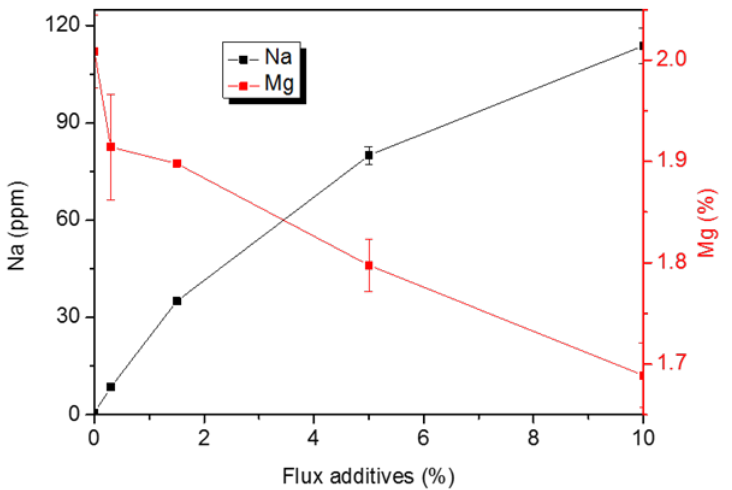
Figure 2. Effect of NK – NaF flux on the residual content of sodium in Al – Mg alloys.